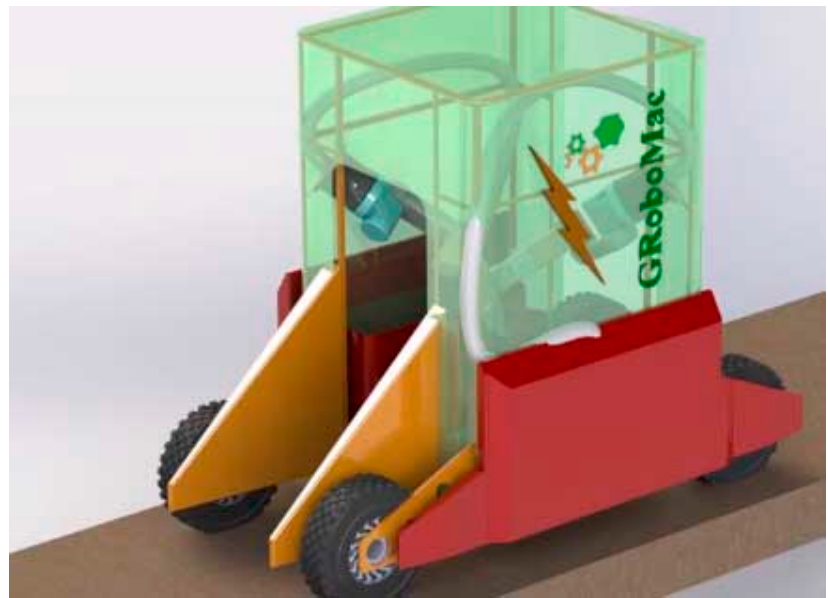
Figure 7. Cotton picker robot prototype (source: www.kas32.com).